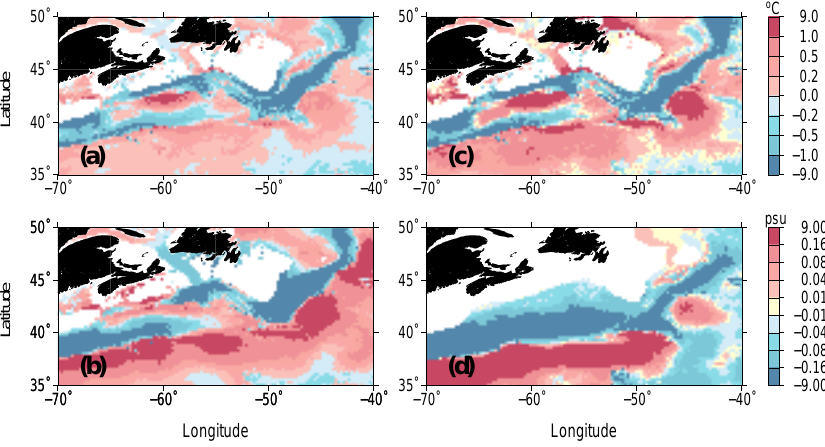
Figure 10. Temperature (a) and salinity (b) differences between the isopycnally averaged and isobarically averaged WAGHC climatology in the northwestern Atlantic at the 150m level in January; (c, d) same but for the isopycnally averaged WAGHC minus WOA13 differences.